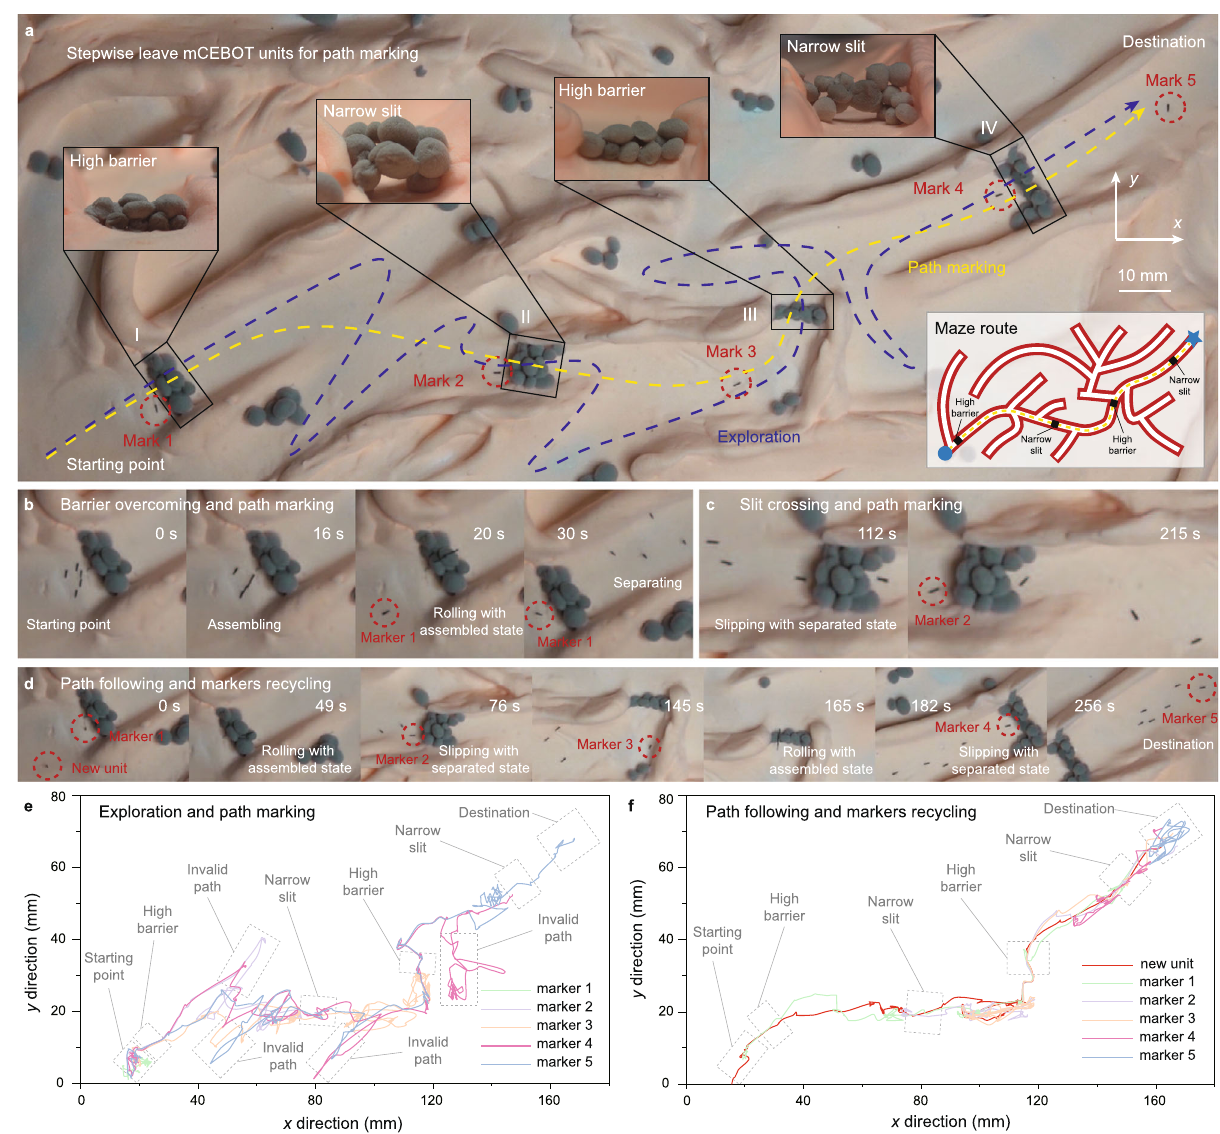
Fig. 6 Demonstration of mCEBOT for environment exploration and path marking. a Schematic diagram of maze route with complex terrain. b Barrier overcoming by assembling units into rolling mCEBOT, and corresponding path marking during exploration. c Slit crossing by units slipping with separated state, and corresponding path marking during exploration. d Path following of new unit, and corresponding markers recycling. e The trajectory of mCEBOT units during environment exploration and path marking. f The trajectory of mCEBOT units during path following and markers